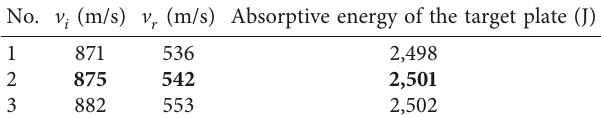
Table 1: Correctness of